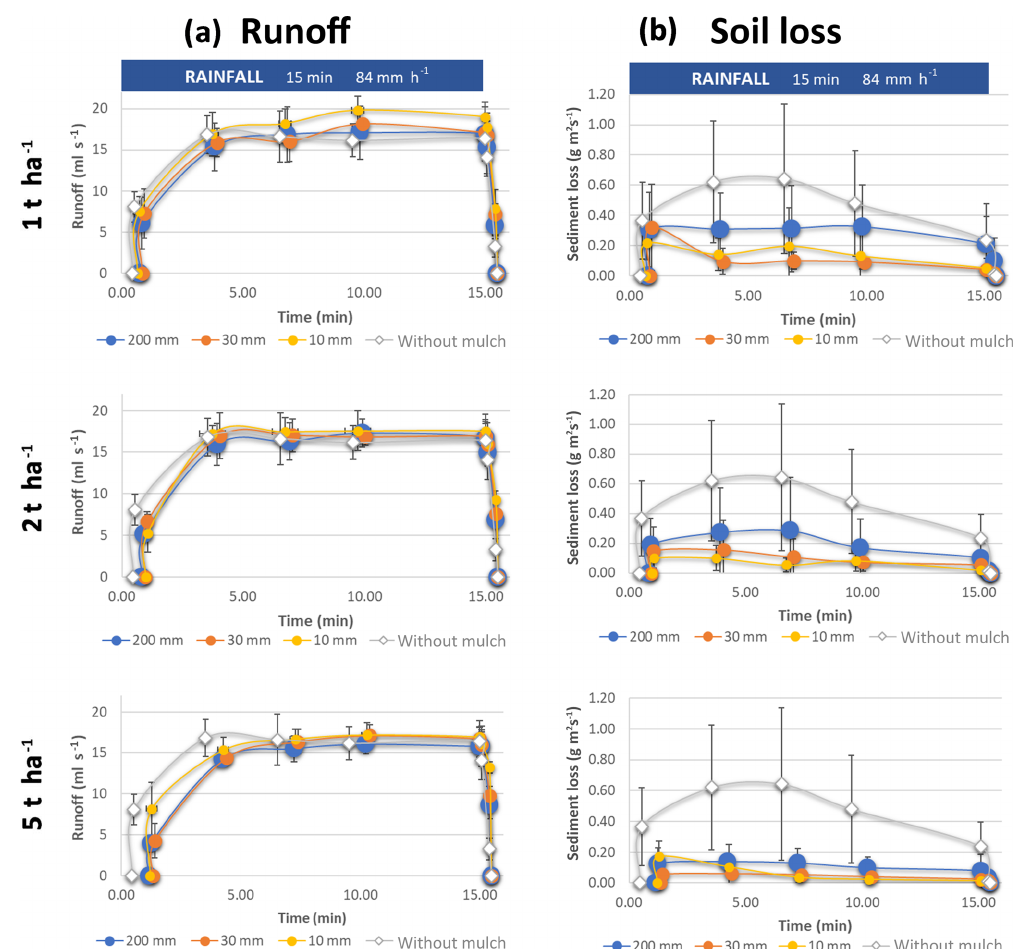
Figure 4. Response to constant intensity simulated rainfall: (a) runoff hydrographs and (b) sediment loss graphs, with average values and standard deviation bars (3